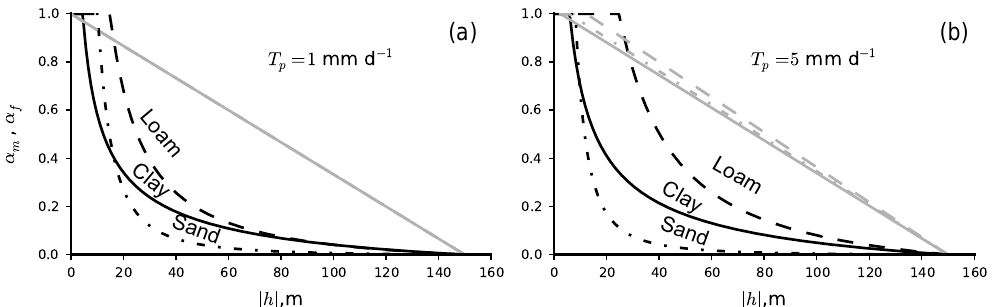
Figure 8. Feddes et al. (1978) ( α f , grey lines) and proposed ( α m , black lines) water uptake reduction functions as a function of soil pressure head h using their respective optimized parameters for the scenario of high root length density, three types of soil, and two potential transpiration